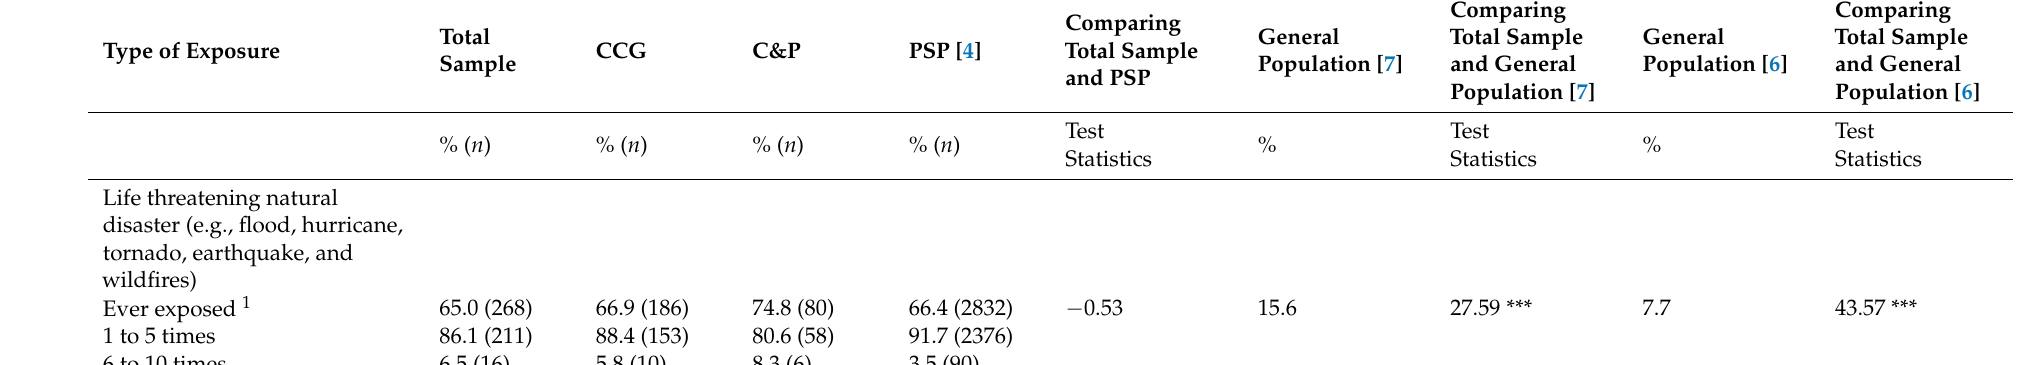
Table 3. Prevalence of Potentially Psychologically Traumatic Events (PPTEs) Exposure